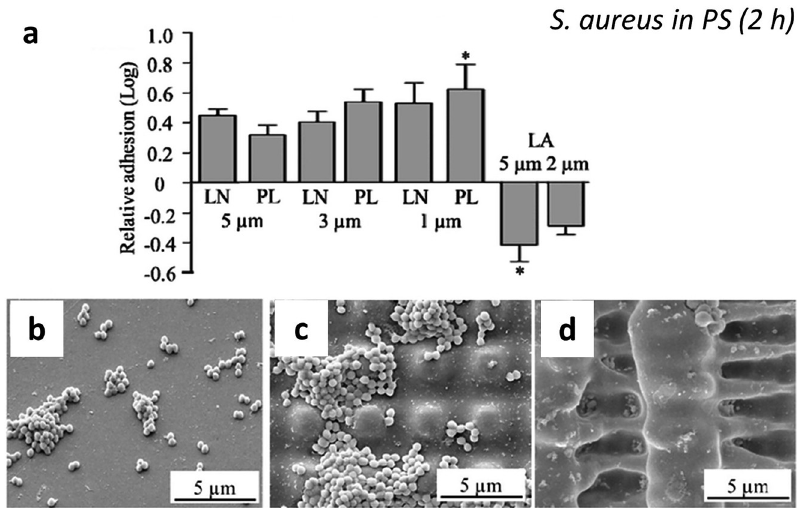
Figure 8: Qualitative assessment of S . aureus adhesion (static conditions, 2 h) to (a) reference PS- fl at compared to (b) pillar- stamped PS (3 μ m) and (c) lamellae PS; (d), relative adhesion (colony forming units (CFU) on structured and unstructured sur- faces of S . aureus in PS with micrometric structures of lines (LN), pillars (PL) and lamellae (LA) at different periodic spacings. Figures reproduced from ref. [97] (© 2016